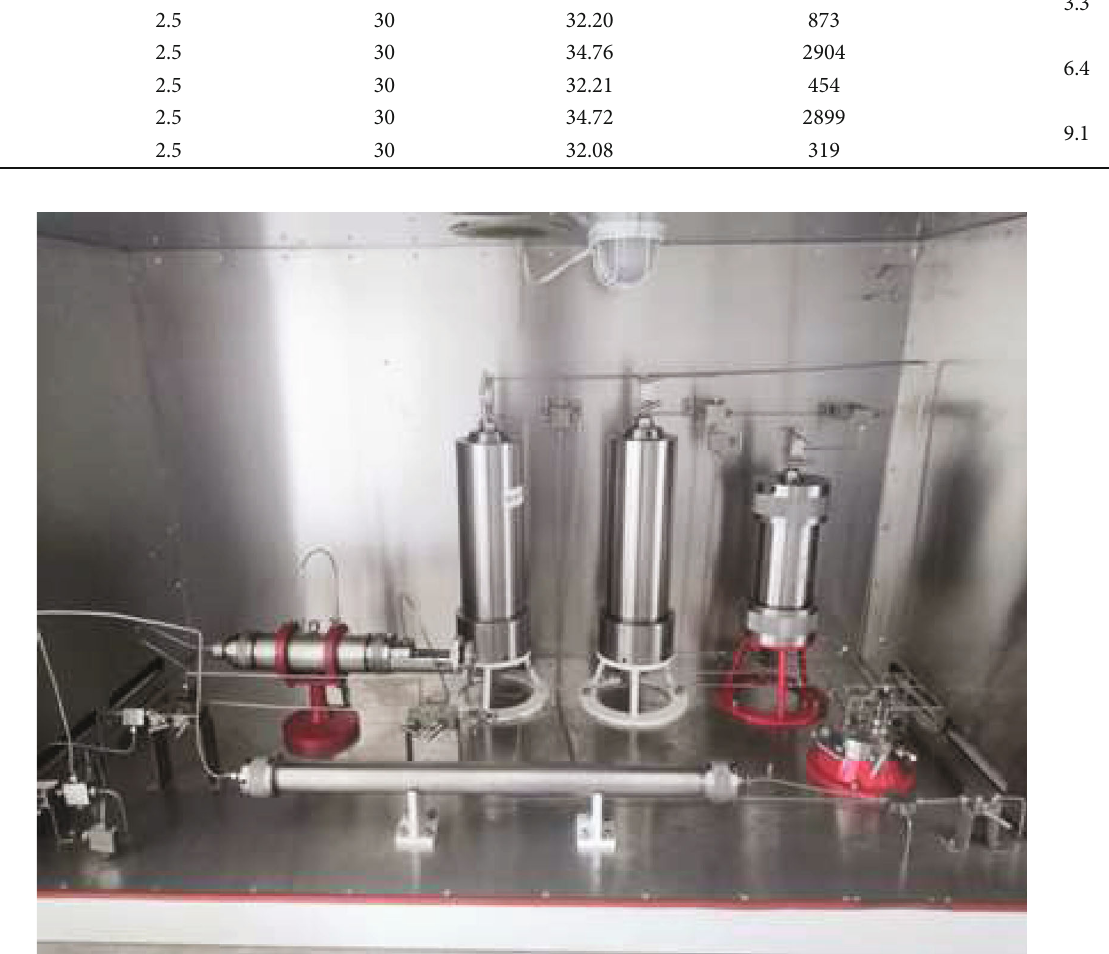
Figure 3: The high-pressure and high-temperature displacement